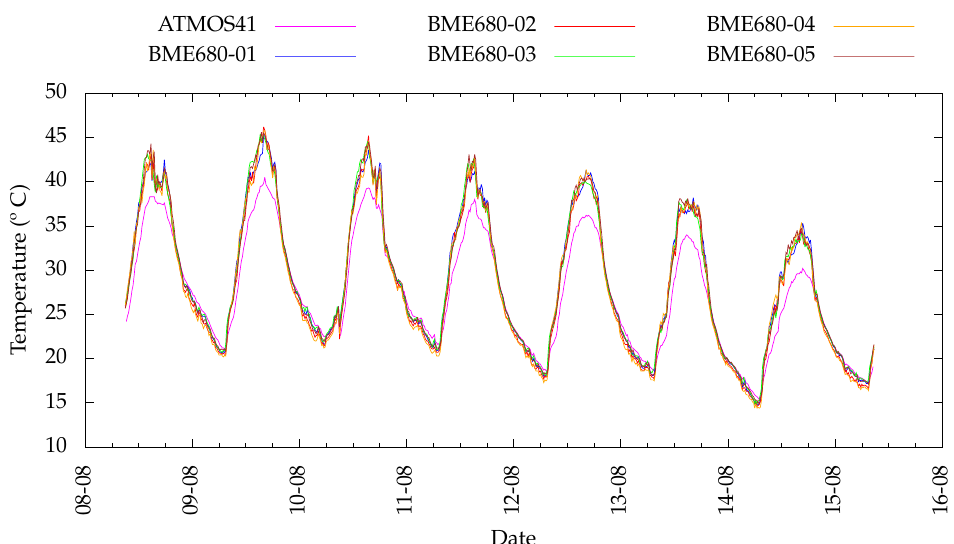
Figure 8. Temperature data from all the ’environment’ devices: ATMOS41, and five devices with the BME680 Bosch sensors.